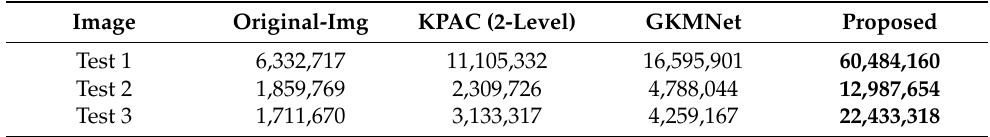
Table 2. Brenner gradient of the images in Figure 12.